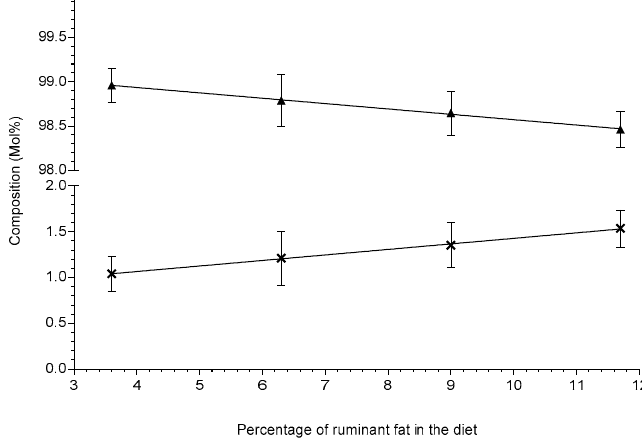
Figure 2. This figure shows the change in the liver lipid concentrations across the four high ‐ fat diets fed to Sprague–Dawley rats (n = 8–9 per group): total odd chain lipids (symbol: X , trendline: